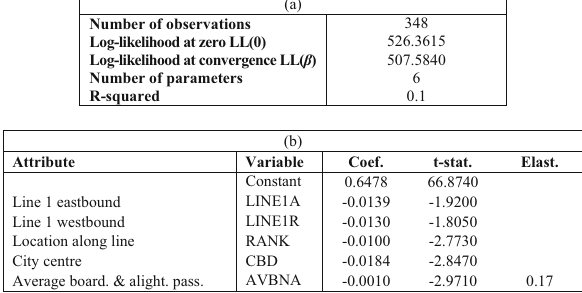
Table 4 Model estimation results for dwell time reliability (a) Number of